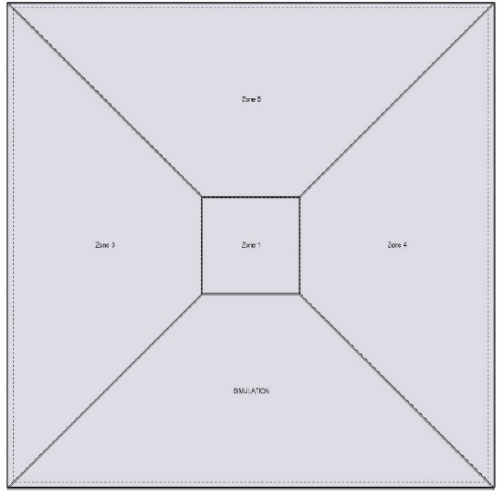
Figure 5 Schematic plan of the case building